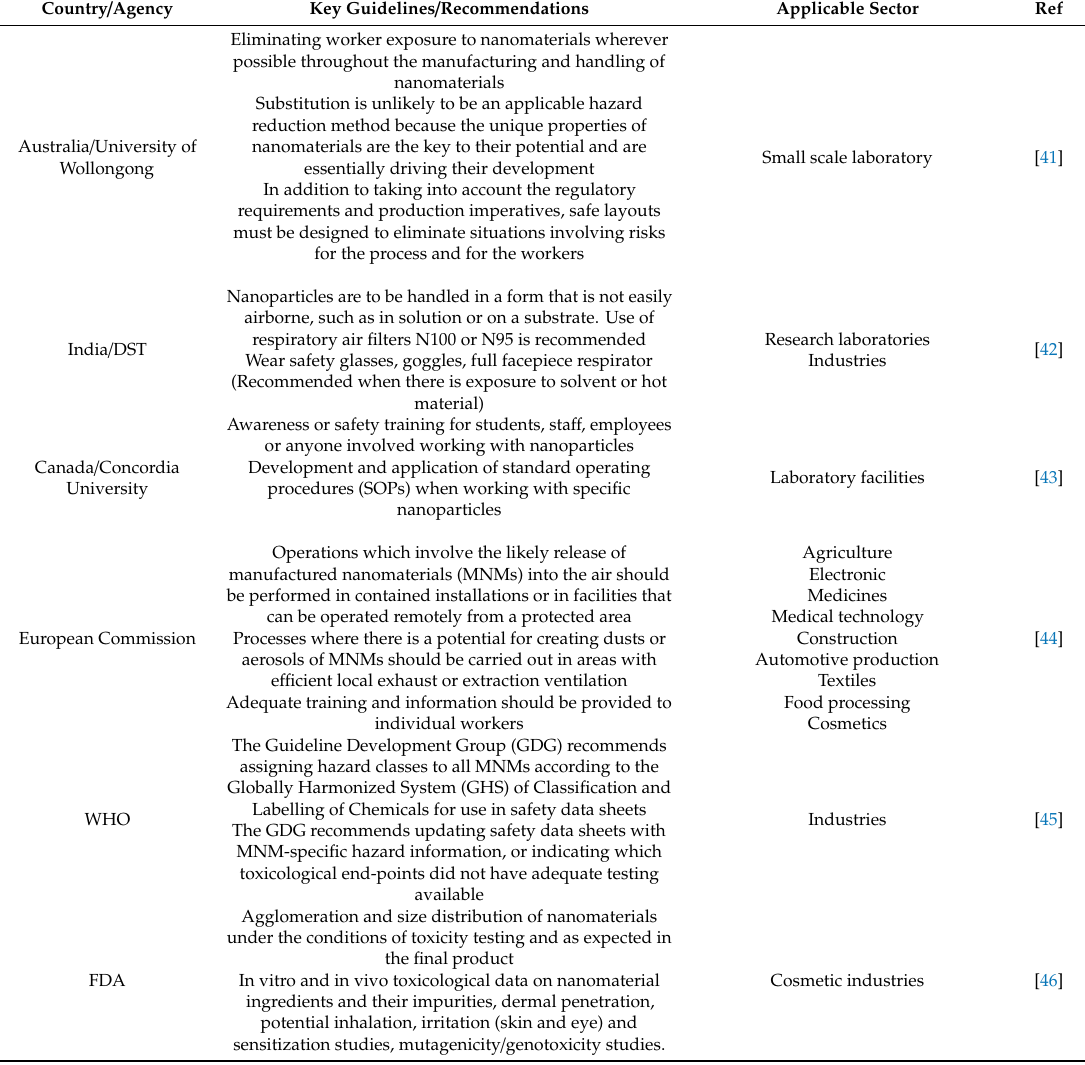
Table 3. Guidelines / recommendations to address the safety of nanomaterials used in sensor fabrication. Country /